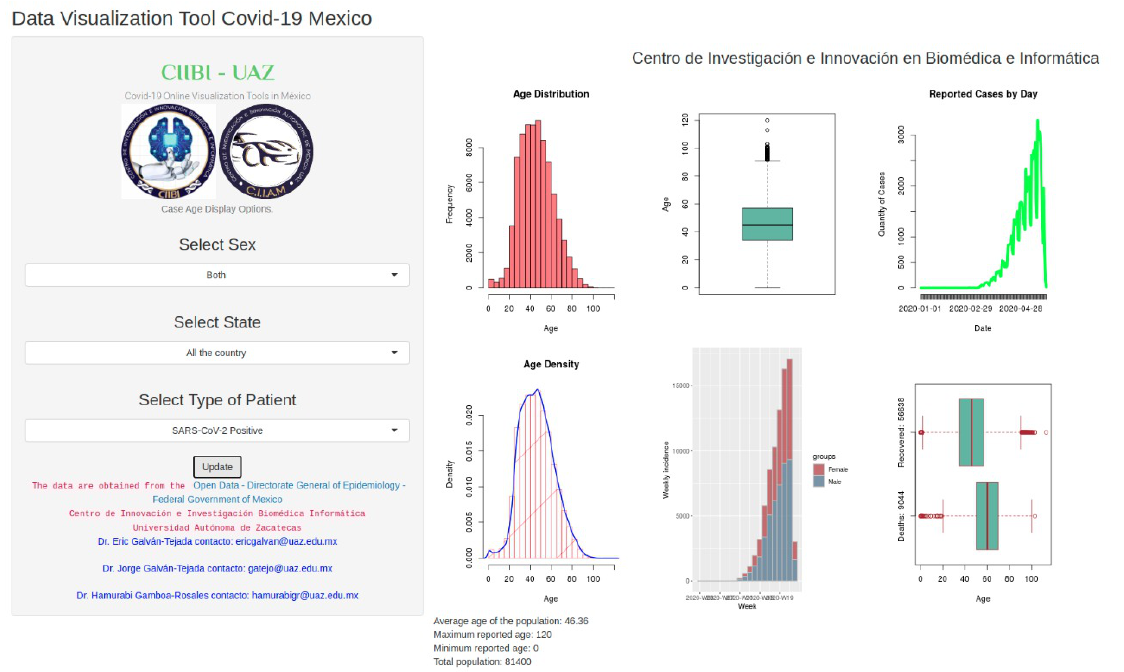
Figure 2. Layer of the web interface that allows to analyze the behavior of COVID-19 based on demographic information.